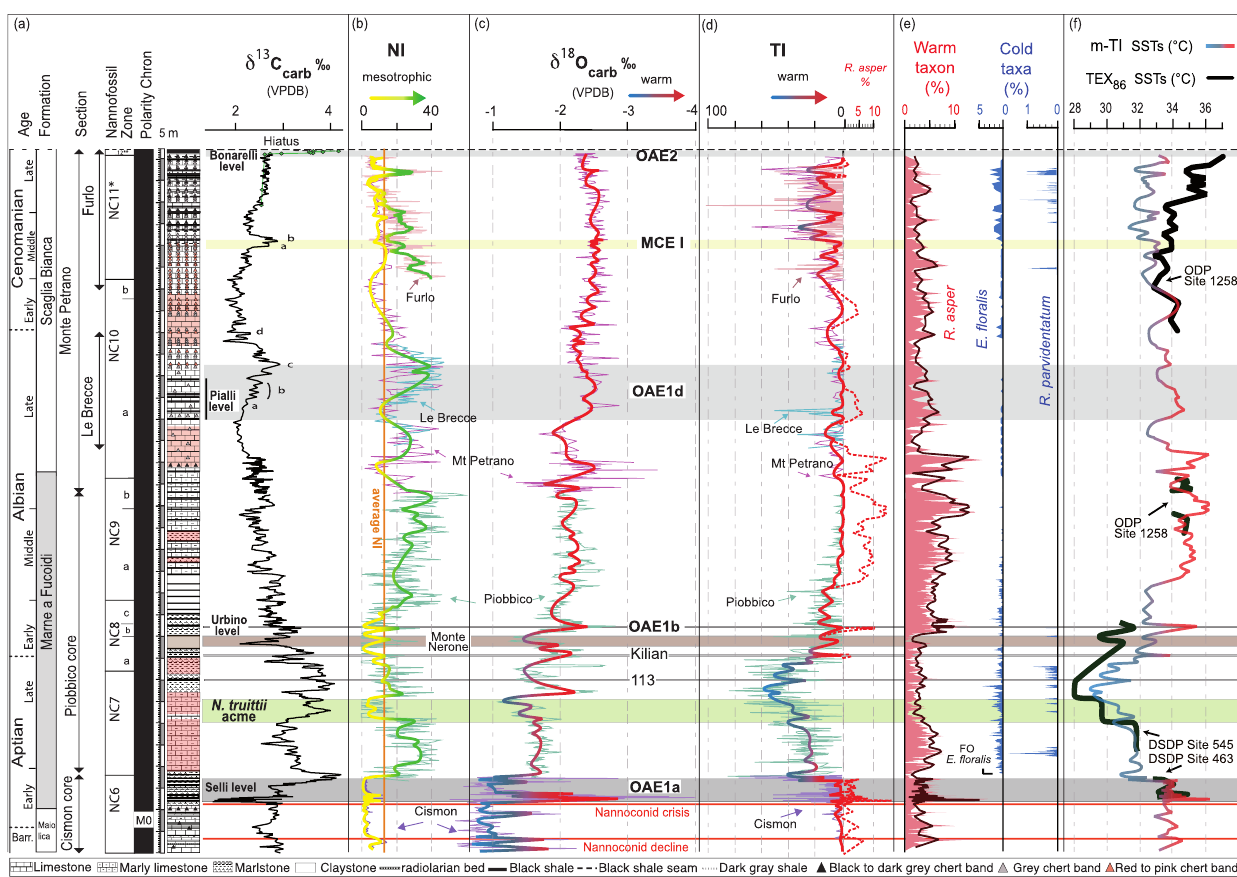
Figure 6. (a) Composite section through the uppermost Barremian–Cenomanian, which includes the following from bottom to top: (i) Cis- mon core, (ii) Piobbico core, (iii) Monte Petrano, Le Brecce and Furlo sections. Nannofossil zones are from Erba (1988), Tiraboschi et al. (2009), Erba et al. (1999), Gambacorta et al. (2015). δ 13 C curve (5-point moving average); (b) nannofossil nutrient index (NI). The NIs of Furlo and Monte Petrano are both presented since the two NI records are interpreted to reflect local conditions. (c) Point by point δ 18 O and 5-point moving average; (d) nannofossil temperature index (TI). The dotted red line is based on R. asper relative abundance; (e) relative abundance (%) of R. asper and cold-water species ( E. floralis and R. parvidentatum ); (f) modified TI (m-TI, ◦ C) takes into account R. asper abundance (%) and is calibrated with TEX 86 SSTs ( ◦ C) recalculated following Kim et al. (2010). TEX 86 SSTs include data from (i) DSDP site 463 (Schouten et al., 2003); (ii) DSDP site 545 (McAnena et al., 2013); (iii) ODP sites 1258 and 1259 (Forster et al., 2007). δ 13 C and δ 18 O include data from the (i) Cismon core (Bottini et al., 2015), (ii) Piobbico core (Tiraboschi et al., 2009 and Bottini et al., 2015) and (iii) Monte Petrano (Giorgioni et al., 2012; Gambacorta et al., 2015). Nannofossil TI and NI composite curves include nannofossil data from (i) the Cismon core (Bottini et al., 2015); (ii) the Piobbico core (Tiraboschi et al., 2009; Bottini et al., 2015); (iii) the Monte Petrano, Le Brecce and Furlo sections (this